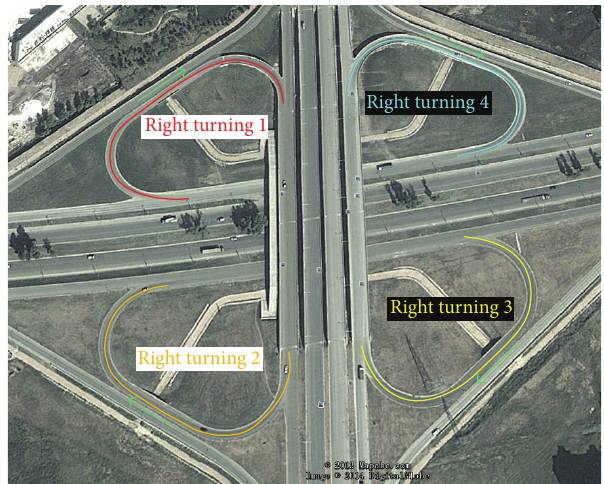
Figure 3: The right-hand bends (map obtained from Google